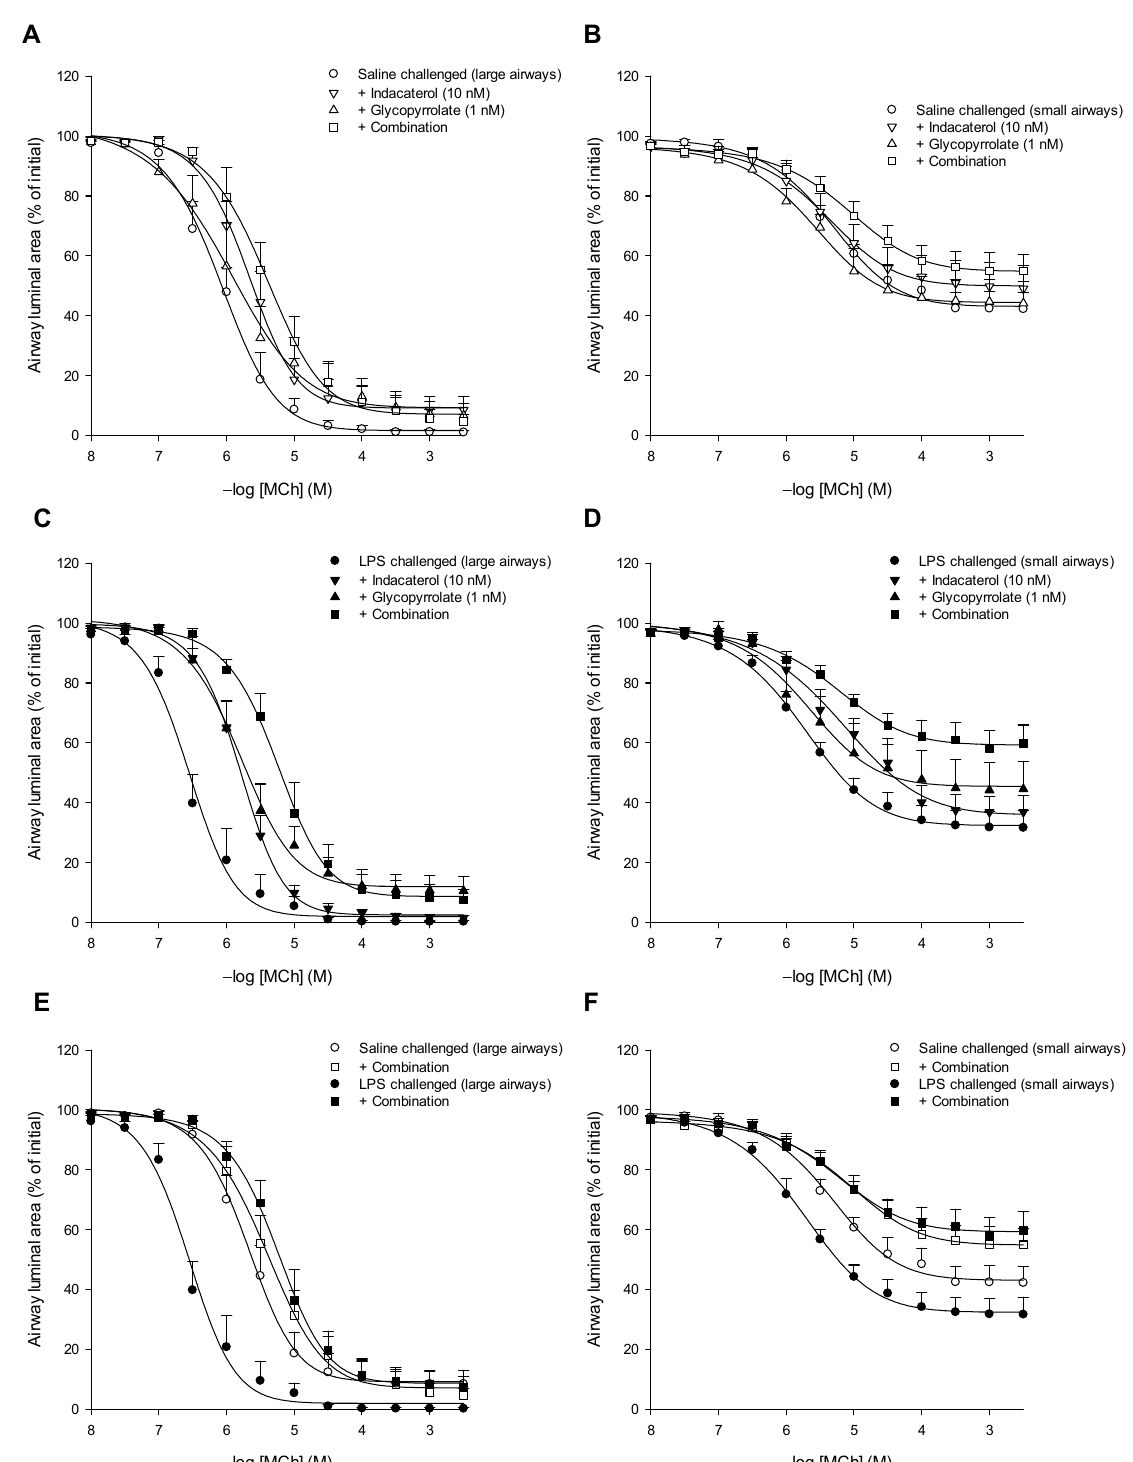
Figure 4. The effect of low concentrations of the β 2 -agonist indacaterol (10 nM) and the anticholinergic glycopyrrolate (1 nM) alone and combined on methacholine (MCh)-induced constrictions of large ( A , C , E ) and small ( B , D , F ) airways in lung slices obtained from guinea pigs that have been challenged twice weekly for 12 weeks with either saline ( A , B ) or LPS ( C , D ). Lung slices were incubated with indacaterol (10 nM), glycopyrrolate (1 nM) or the combination of both and the constriction of large (>150 µ m) and small (<150 µ m) airways to increasing concentrations of methacholine (MCh) was determined by measuring the luminal area as a percentage of baseline. Data are represented as means ± SEM of 6–10 guinea pigs (see also Table